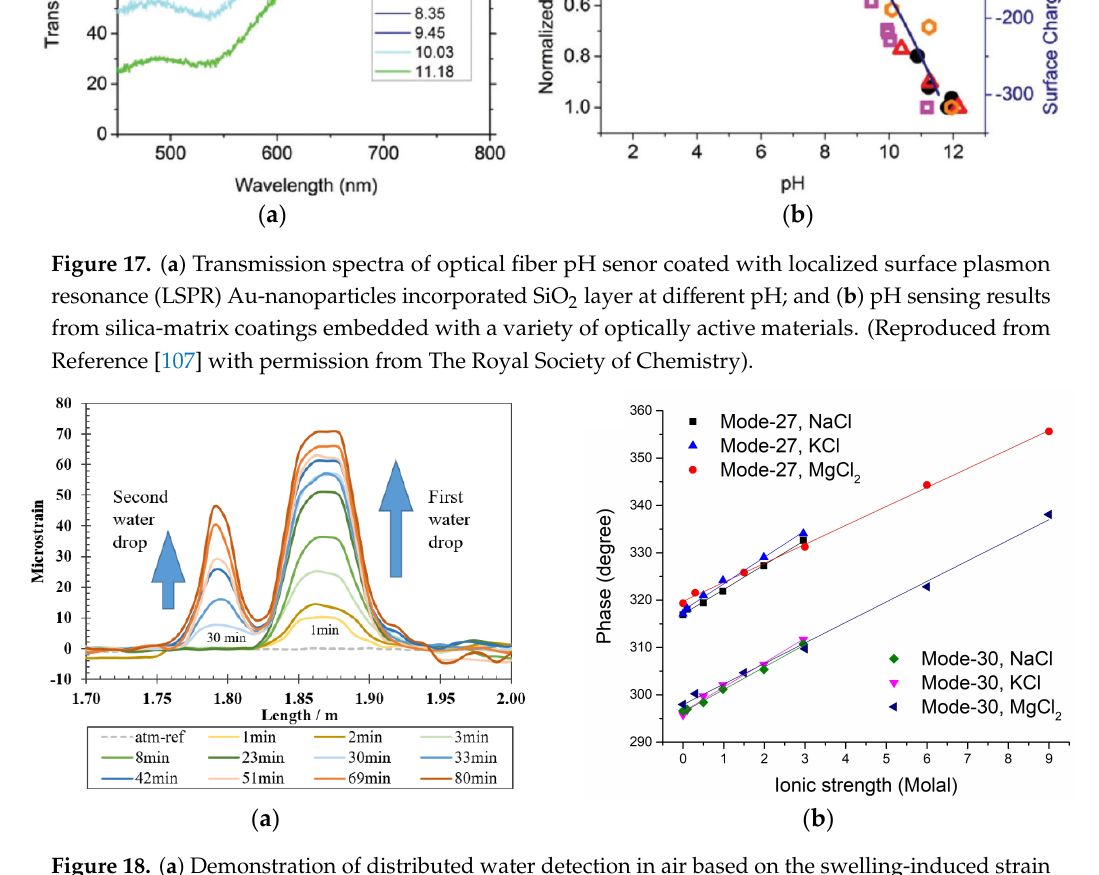
Figure 18. ( a ) Demonstration of distributed water detection in air based on the swelling-induced strain changes interrogated with an optical backscatter reflectometer (OBR). The first water drop was added at 1 min and the second water drop was added at 30 min [138]; ( b ) Phase shift-based optical fiber sensor (OFS) without any additional coating for simultaneous multi-parameter monitoring including ionic strength as a corrosivity indicator [119]. Table 2. Chemical sensing parameters and examples of optical fiber sensing layers for corrosion monitoring. Parameter